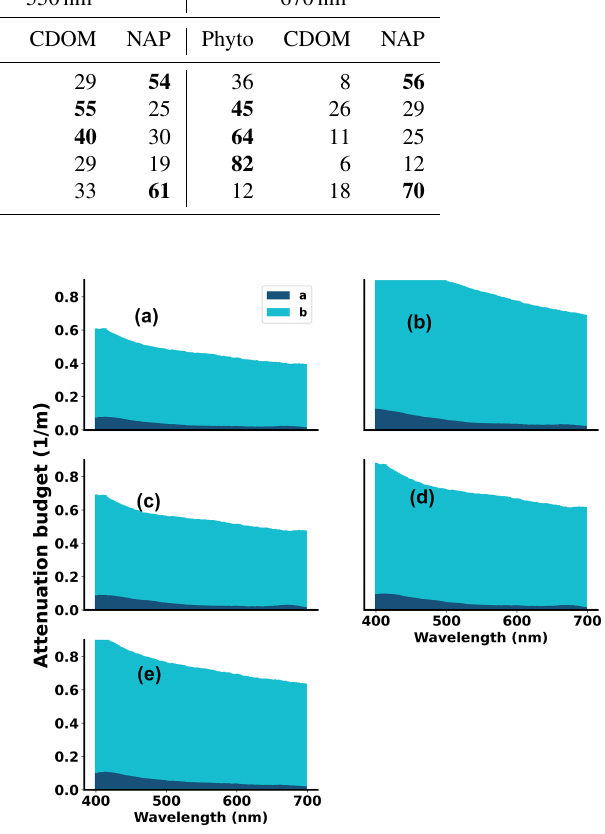
Figure 11. Attenuation budget for five typical cases, correspond- ing to (a) northern surface (NSurf), (b) southern surface (SSurf), (c) northern subsurface (NSub), (d) southern subsurface (SSub), and (e) dense bottom water (Bott). Surface (subsurface) water is defined as < 15m (15–60m) water depth. The dense bottom water corresponds to the layer trapped by the sill at stations 505, 508, and 509. Dark blue corresponds to absorption and light blue to scatter-